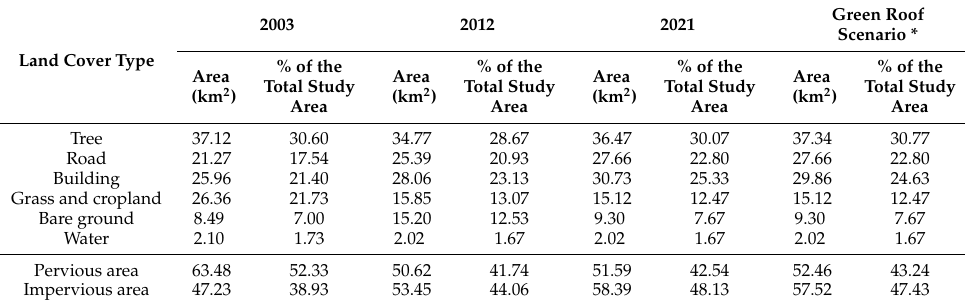
Table 1. Land cover type by year and green roof scenario.